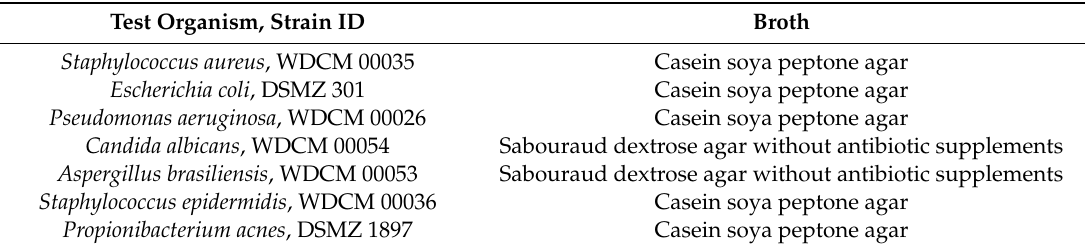
Table 2. Overview of the test organism and the used